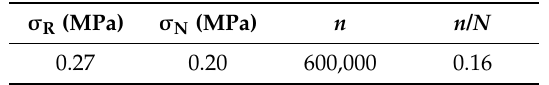
Table 12. Fatigue analysis for cement-bound base course—block